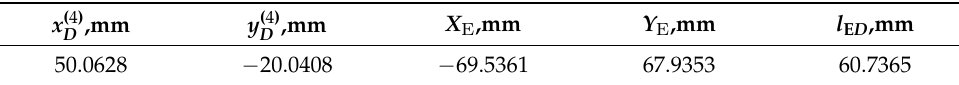
Table 3. Synthesis parameters of the negative CKC DE .